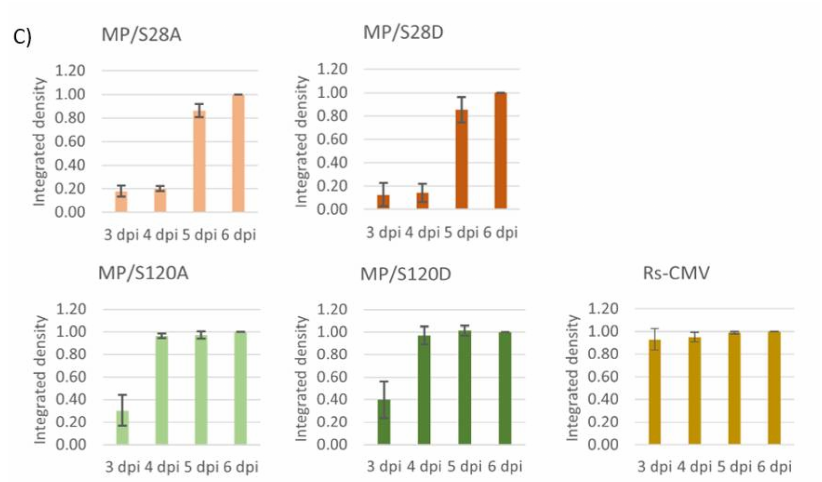
Figure 1. Symptom development on Nicotiana tabacum cv. Xanthi induced by MP/S28A, MP/S28D, MP/S120A, MP/S120D and wild type Rs-CMV. ( A ) Systemic symptoms on N. tabacum cv. Xanthi plants 5 days post inoculation (dpi). Arrows indicate the recognized symptoms. ( B ) Western blot analysis of coat protein (CP) accumulation in the systemically infected leaves 3–6 dpi. The equal protein loading was verified with Coomassie staining. ( C ) Bar diagrams representing the relative inte- grated density of the Western blot analysis. Standard deviations from three independent experiments are